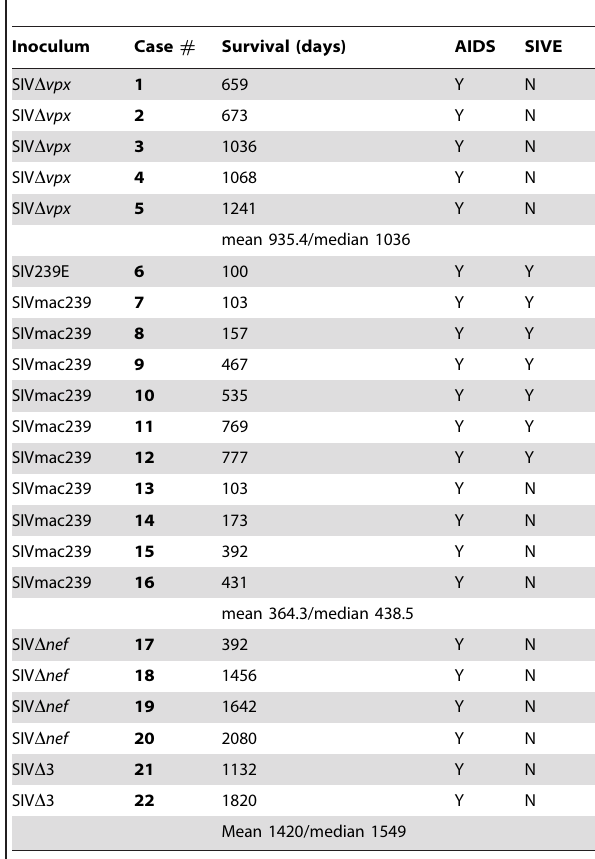
Table 1. Study cohort of SIV D vpx (n=5) and SIVmac239 (n=11) with and without